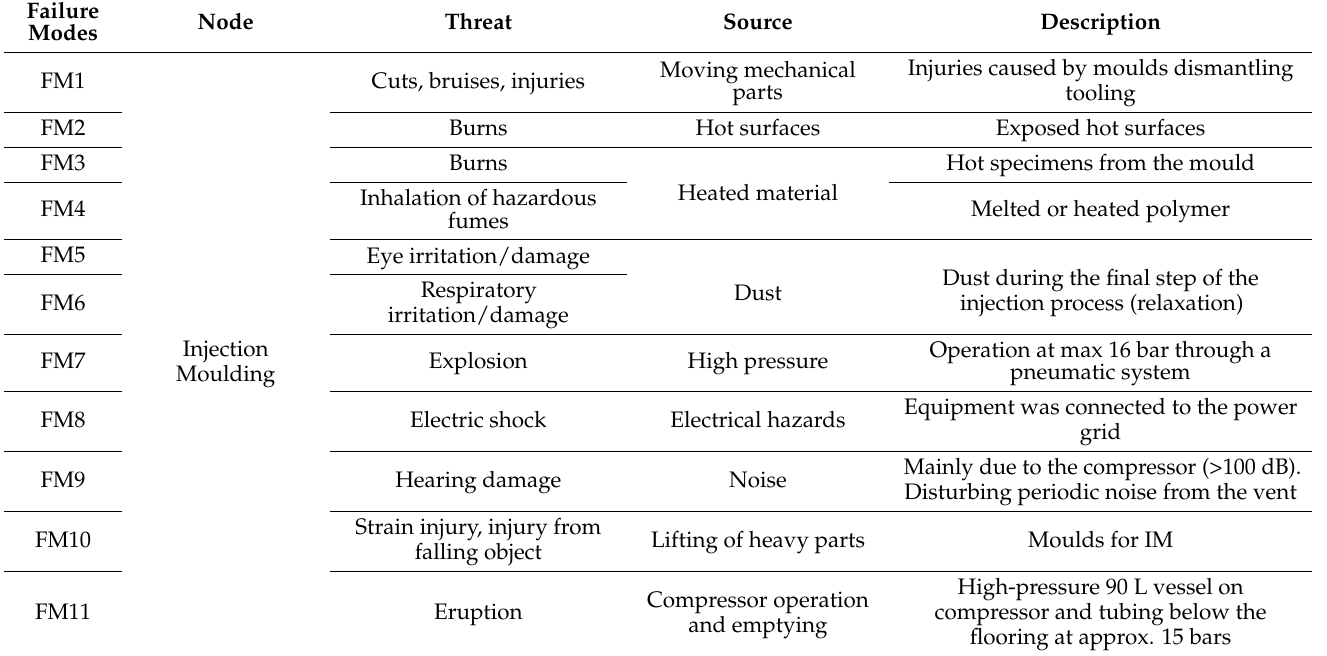
Table 2. Failure modes per piece of equipment of the repurposed injection moulding line. Failure